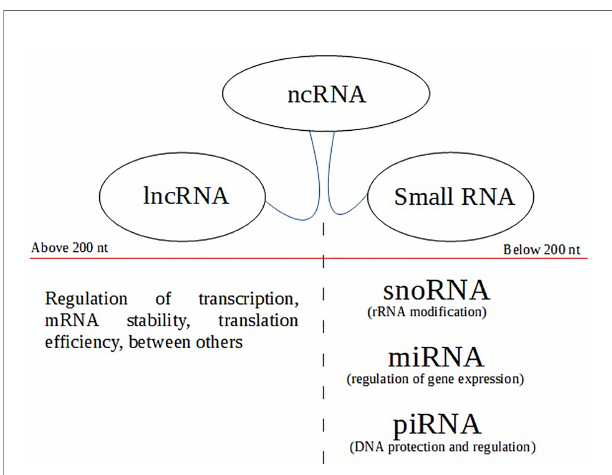
FIGURE 1 | The top of the fl owchart (balloons) represents non-coding RNA types based on transcript length (nt). Below the nt size divider (red line) are the subclass with their respective